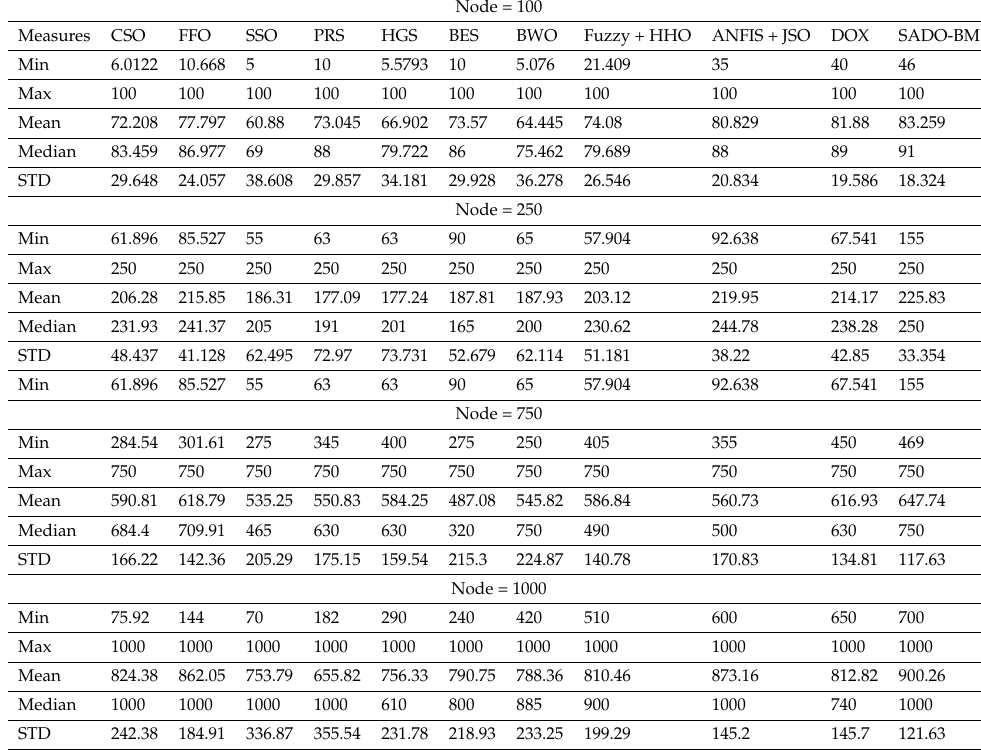
Table 4. Statistical Analysis for SADO-BM Over Other Models Regarding Alive Nodes. Node =